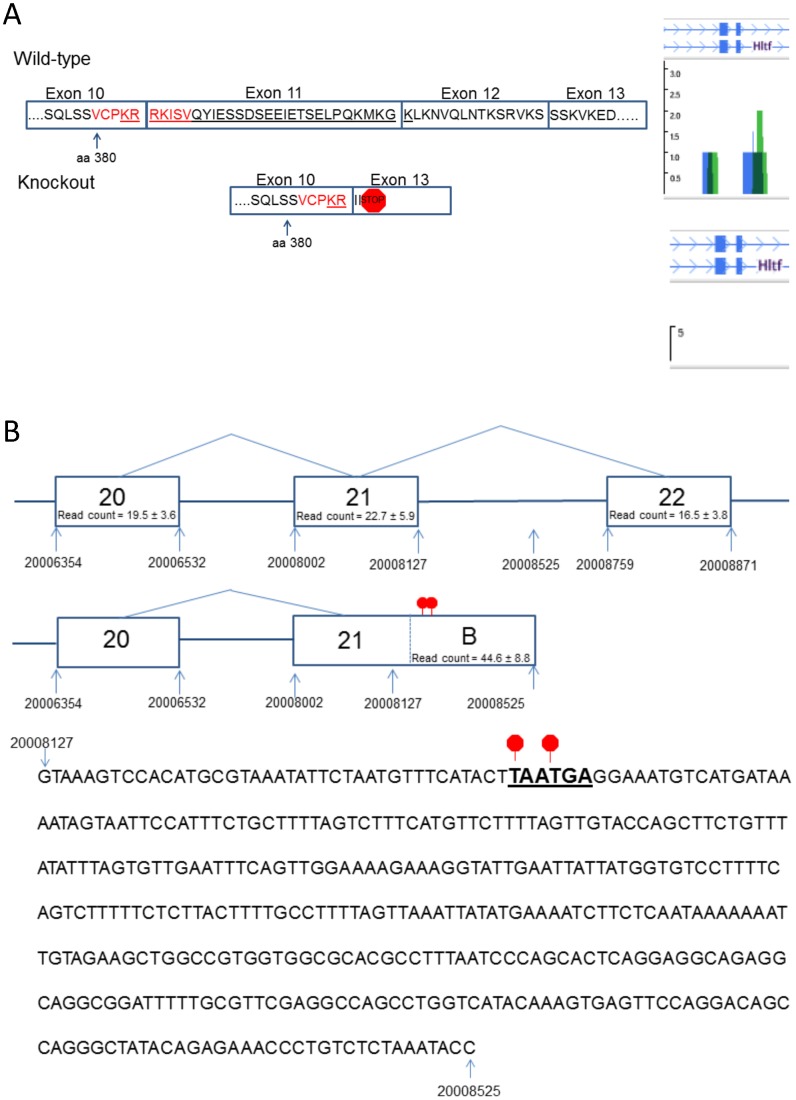
Splicing events in Hltf.Panel A, diagram showing the presence (wild-type) and absence (Hltf null) of sequences encoding the NLS, and a DNAnexus genome browser screen shot of RNA-seq data verifying deletion of the sequences from Hltf null transcripts. Panel B, illustrates partial intron inclusion event (B) that produces Hltf isoform 2, which ends abruptly in dual stop codons.